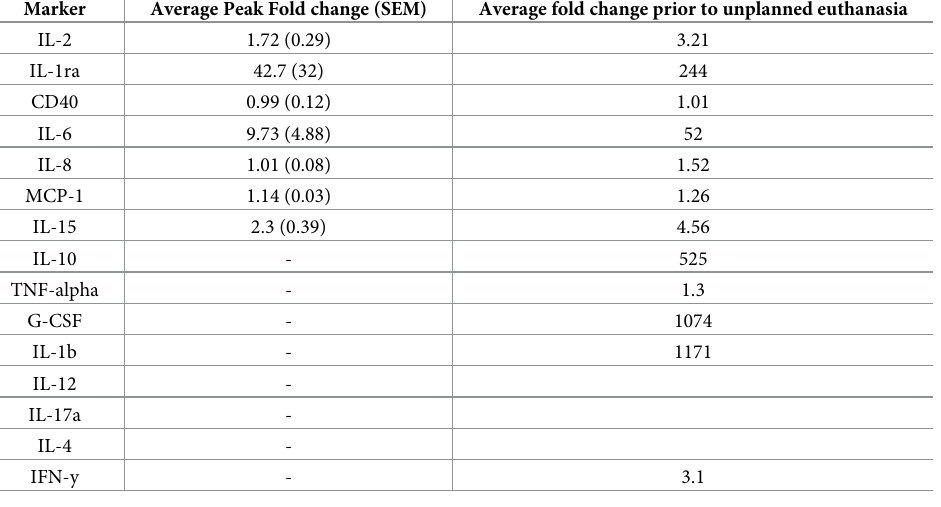
Table 2. Fold changes for various